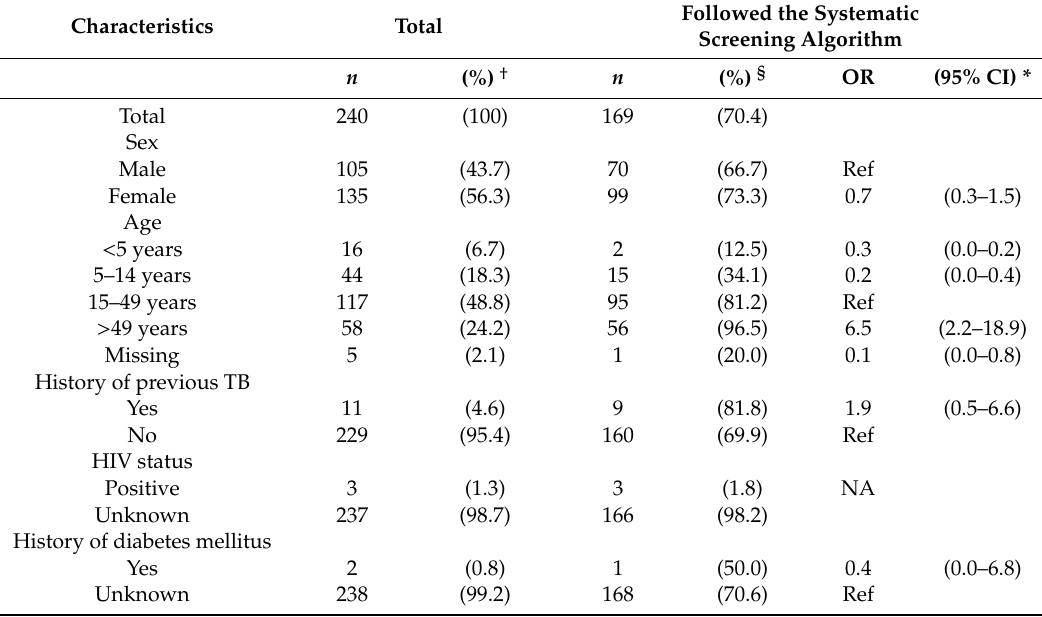
Table 1. Characteristics of symptomatic household contacts of MDR-TB patients, and their association